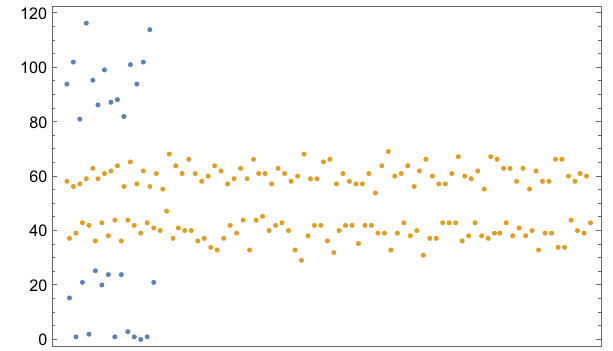
Fig. 11 Errors of spectral clustering in case when the corresponding classifier has high error rate, for a fixed sample graph with The points correspond to nodes. Nodes exactly at diagonal are cor- rectly clustered, and those off the diagonal are in wrong clusters. In case of applying RD to the same graph the nodes are 100% correctly clustered